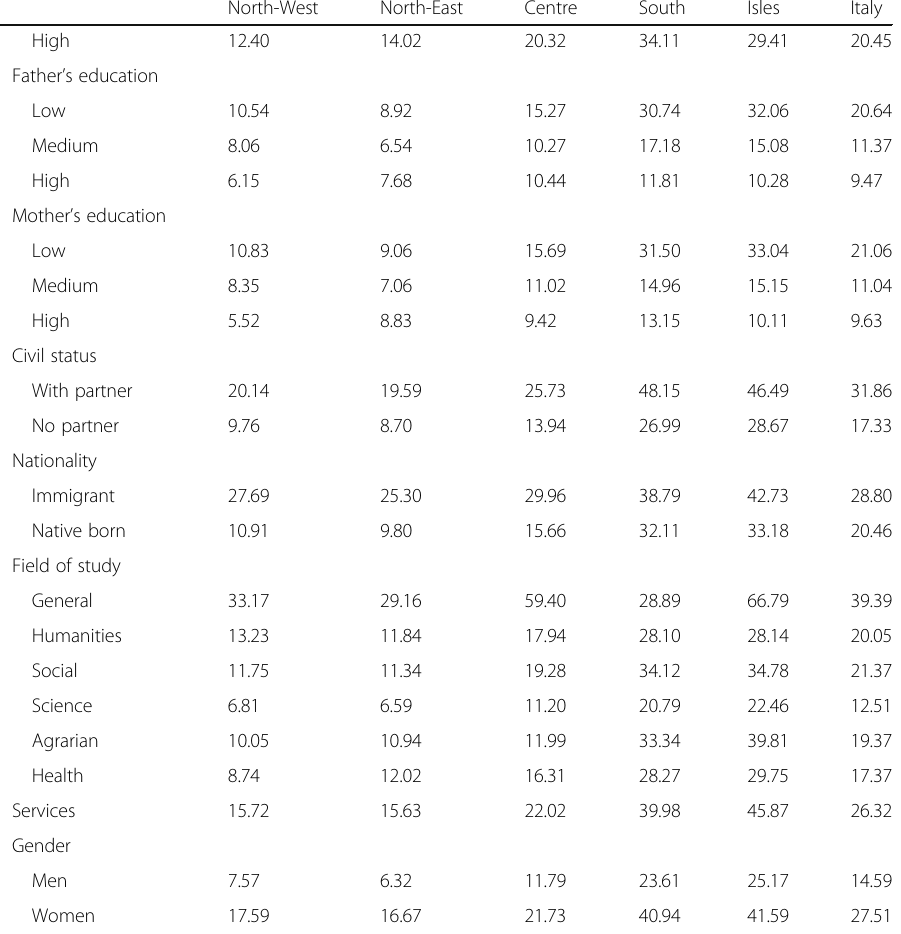
Table 1 Share of NEETs in the Italian macro-regions according to some personal characteristics (*)